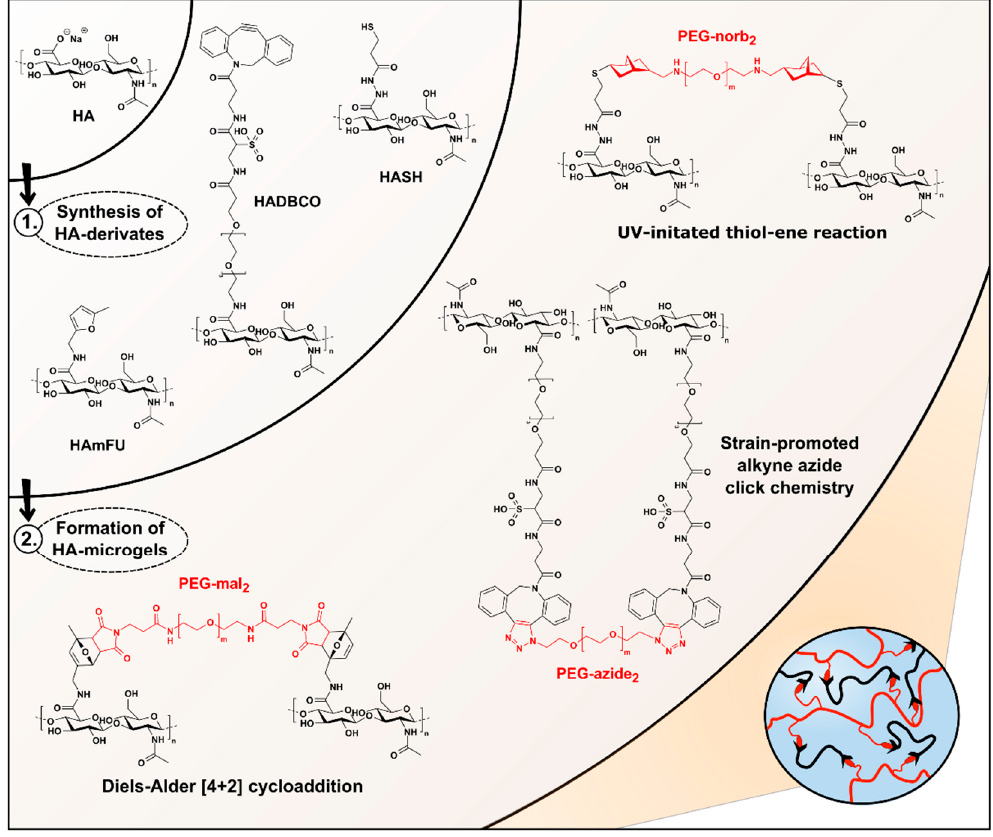
Figure 1. Overview of HA-microgel design based on Diels–Alder [4 + 2] cycloaddition, SPAAC, and UV-initiated thiol–ene reaction. Upon DMTMM-mediated synthesis of HA-derivates, HASH-, HADBCO-, and HAmFU-microgels are microfluidically prepared by crosslinking HASH, HADBCO, and HAmFU with PEG-norb 2 , PEG-azide 2 , and PEG-mal 2 , respectively.